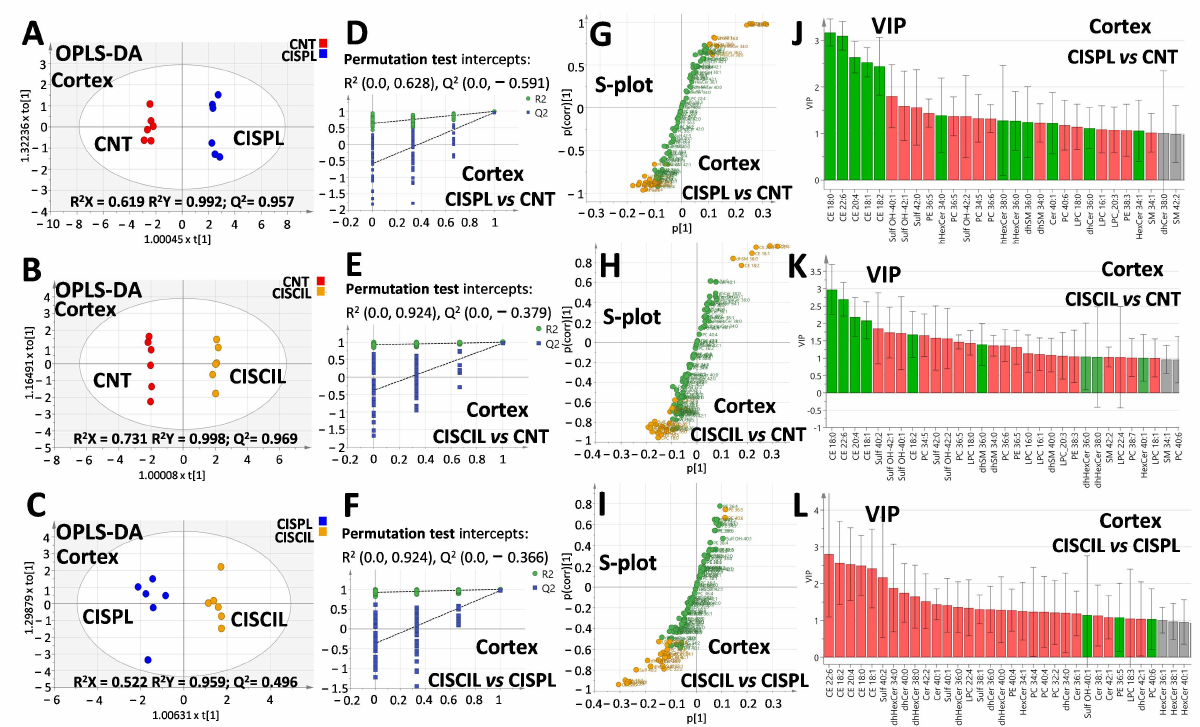
Figure 9. OPLS-DA analysis for renal cortex lipids. Score plots for ( A ) CISPL vs. CNT groups, ( B ) CISCIL vs. CNT groups, and ( C ) CISCIL vs. CISPL groups. Permutation tests based on 100 iterations for the models for ( D ) CISPL vs. CNT, ( E ) CISCIL vs. CNT, and ( F) CISCIL vs. CISPL. S-plots are presented with those features with both |p(corr)| > 0.5 and VIP > 1 marked in orange for ( G ) CISPL vs. CNT, ( H ) CISCIL vs. CNT, and ( I ) CISCIL vs. CISPL. VIP plots are presented in green and red for features with a value >1, with an increasing and decreasing trend, respectively; for ( J ) CISPL vs. CNT, ( K ) CISCIL vs. CNT, and ( L ) CISCIL vs.